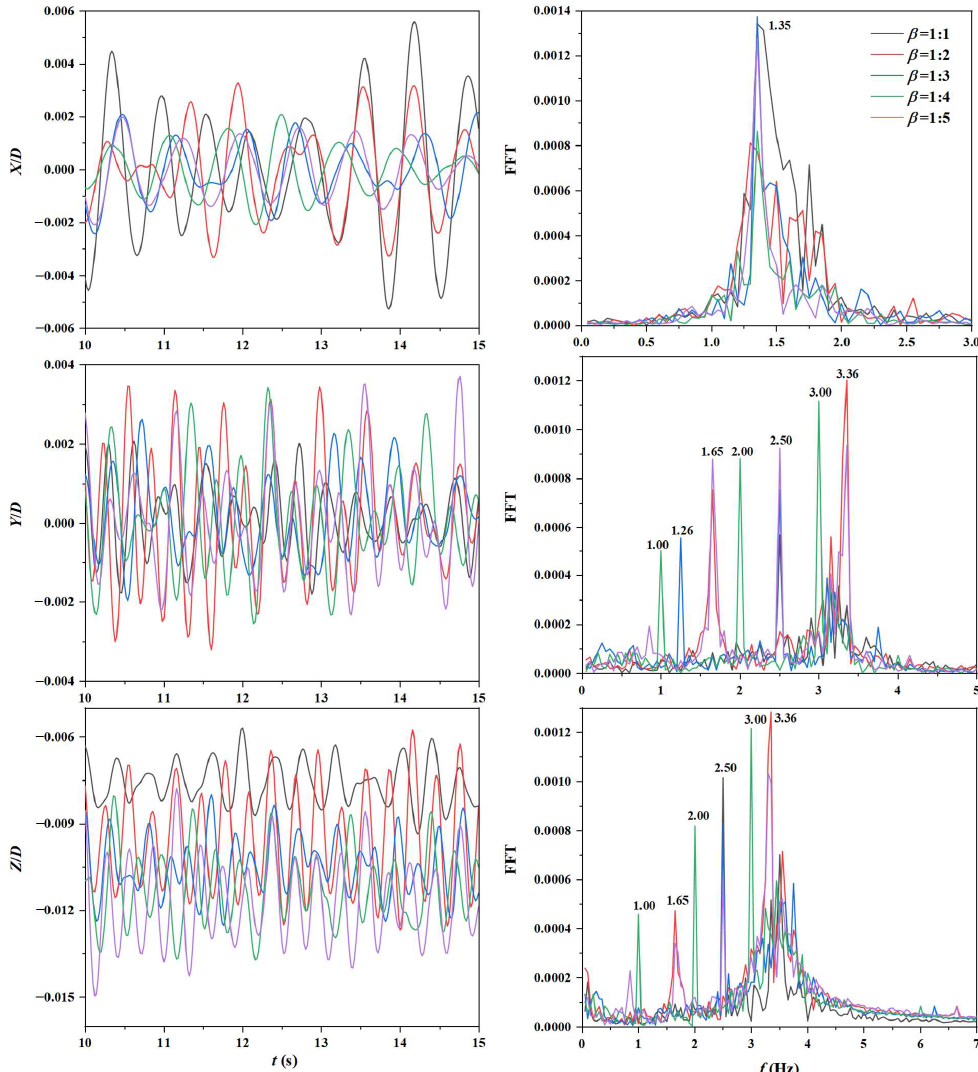
Figure 15. Comparison of the vibration response of the midspan of bottom horizontal span (Probe C) at different gas-liquid ratios, where β is the gas-liquid ratio, and X / D , Y / D and Z / D are the normalized displacements in the three directions.